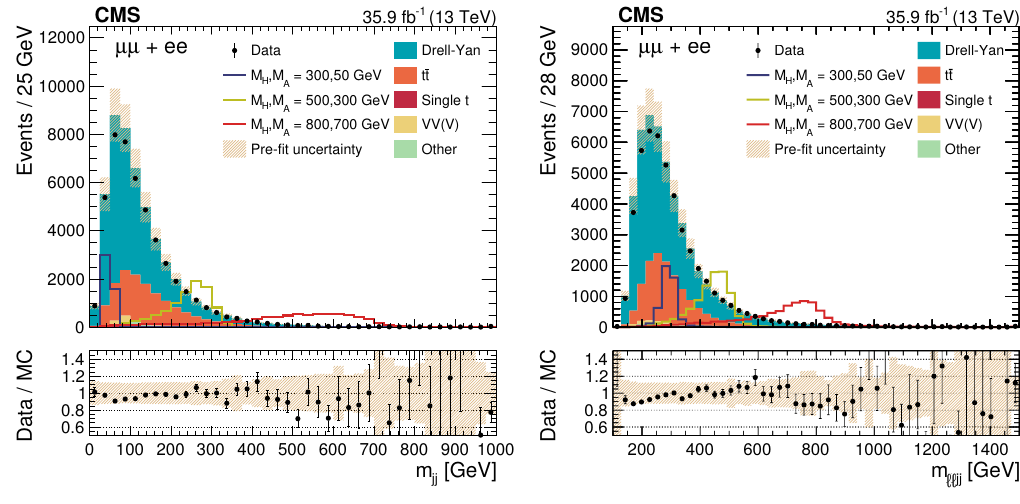
Figure 3 . The m (left) and m (right) distributions in data and background events after jj ‘‘ jj requiring all the analysis selections, for (cid:22)(cid:22) +ee events. The background shapes and normalisations are obtained from simulation. The various signal hypotheses displayed have been scaled to a cross section of 2 pb for illustrative purposes. Error bars indicate statistical uncertainties, while shaded bands show systematic uncertainties prior to the (cid:12)t (introduced in section